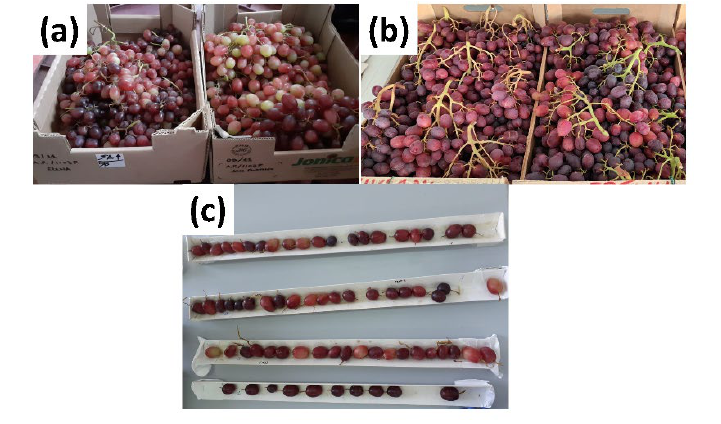
Figure 1. Grapes belonging to A and C ( a ), D and B classes ( b ) upon arrival in the laboratory; ( c ) slot of samples prepared for NIR analysis (from bottom to top: A, B, C, and D).